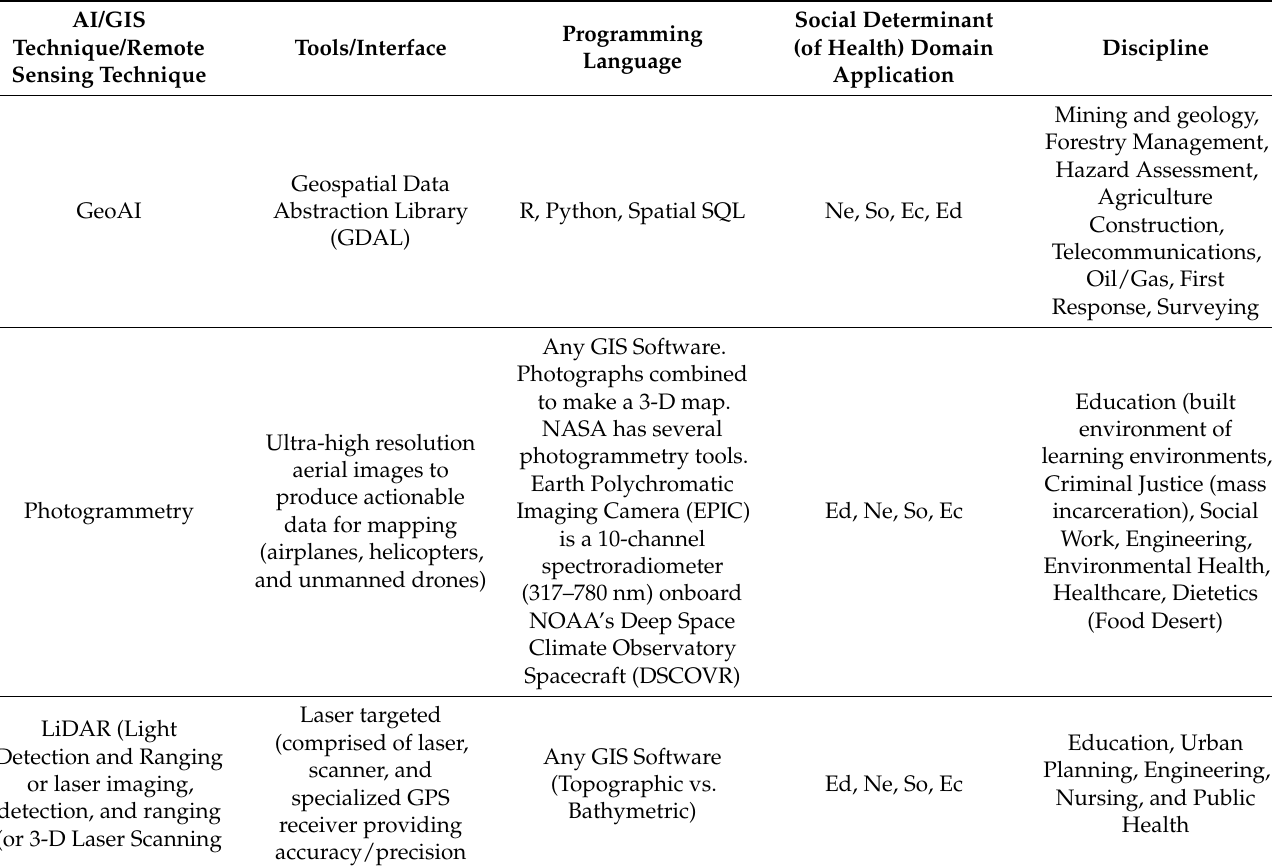
Table 1. GIS and remote sensing to address social determinants and educational disciplines which has broad application in the learner